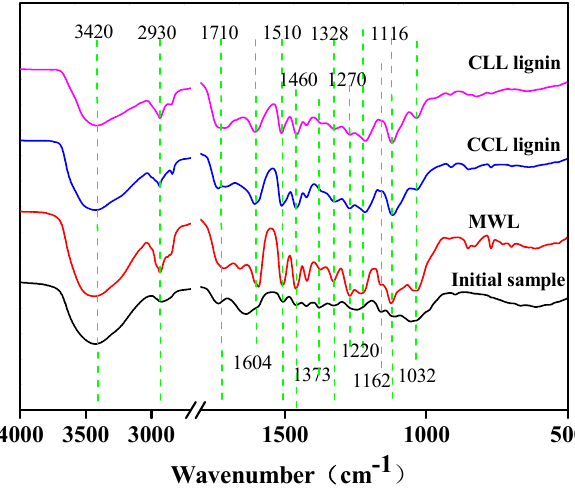
Figure 3. FT-IR analysis of the initial sample milled wood lignin (MWL), CLL lignin and CCL lignin. Table 5. Assignment of FT-IR spectra of the initial sample, MWL, CLL lignin and CCL lignin. Wavenumbers (cm − 1